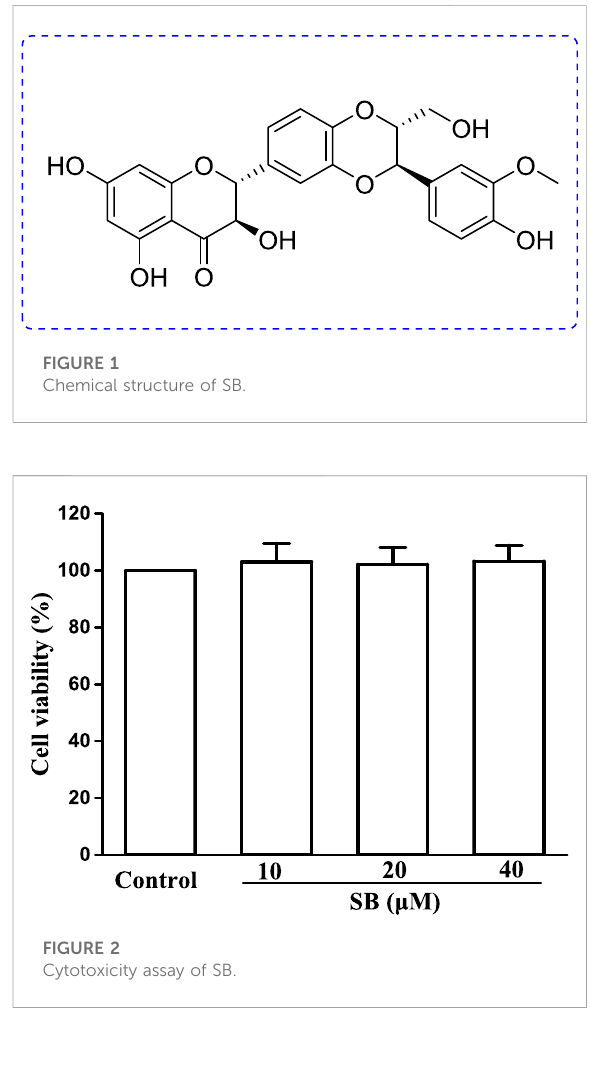
FIGURE 2 Cytotoxicity assay of SB.